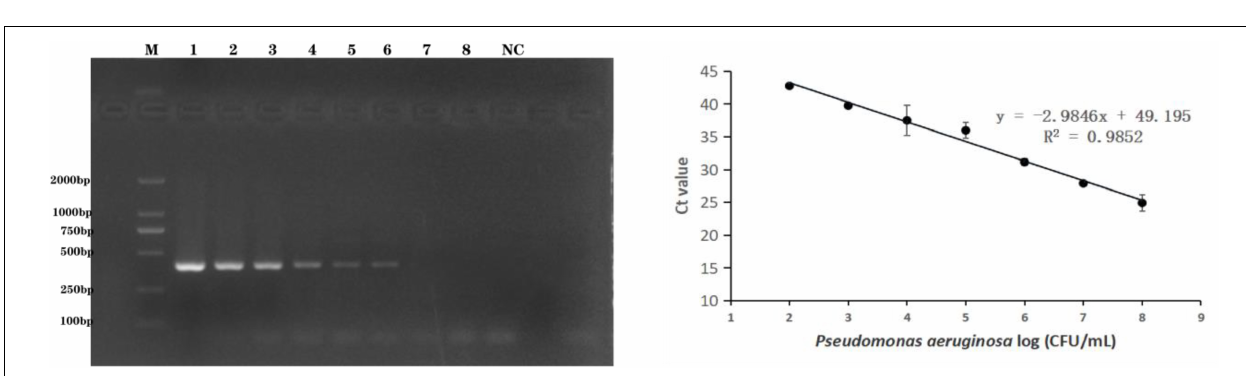
FIGURE 4 | Practical application for the detection of P. aeruginosa serogroup G in spiked drinking water samples. 4.1: Amplification of PCR assay using PA59_01276 primers. Lanes 1–8: Samples spiked with 10-fold dilutions of serogroup G (4.0 × 10 8 CFU/mL–4.0 × 10 1 CFU/mL), lane M: DL DNA 2000 marker; lane NC: negative control. 4.2: Amplification of real-time PCR assay using PA59_01276 primers. Plots of Ct values against the log numbers of P. aeruginosa (4.0 × 10 2 CFU/mL–4.0 × 10 8 CFU/mL) in artificially contaminated drinking